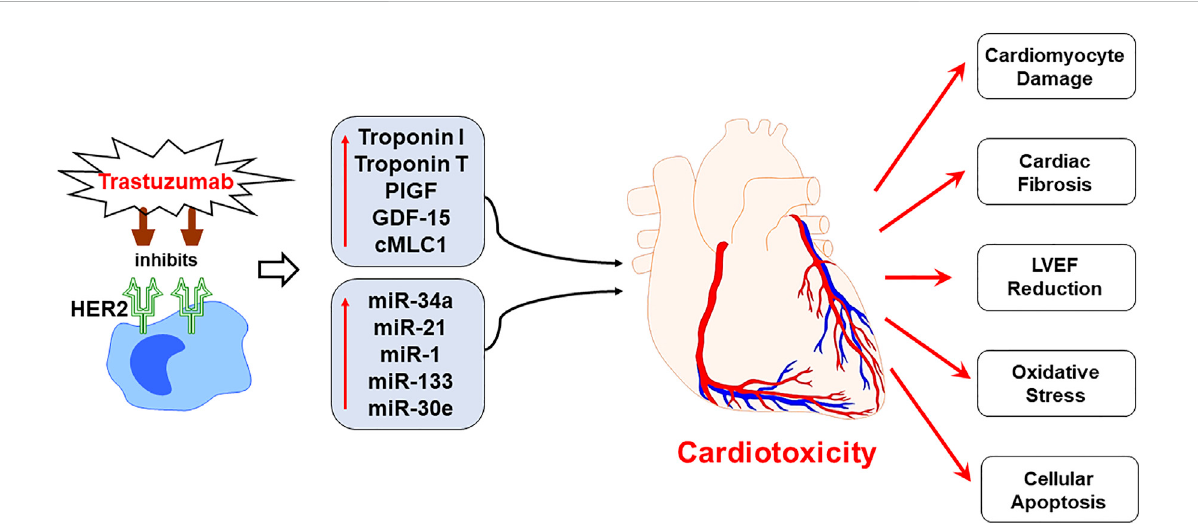
FIGURE 7 Schematic representation demonstrating the progression of trastuzumab induced cardiotoxicity. Chemotherapeutic regimen, trastuzumab, speci fi callyinhibitsthehumanepidermalgrowthfactorreceptor2(HER2)receptortonegatethecancerouscellgrowthandsurvival,asamechanism ofaction.However,trastuzumabtreatmentupregulatestheexpressionofplasmabiomarkersandcirculatingmiRNA,thatareprimarilyinvolvedinthe regulation of cardiac function. The mechanistic action of trastuzumab induces cardiotoxicity by cardiomyocyte damage, cardiac fi brosis, LVEF decline,oxidativestressandcellularapoptosis.SincethepanelofproposedbiomarkersandmiRNAsisspeci fi callyinvolvedinthecardiacremodeling and regulation of cardiac function, their upregulated expression can predict cardiotoxicity before it is apparent on echocardiography. Hence, the utility of the proposed panel in clinical practice is viable for the early prognosis of trastuzumab induced